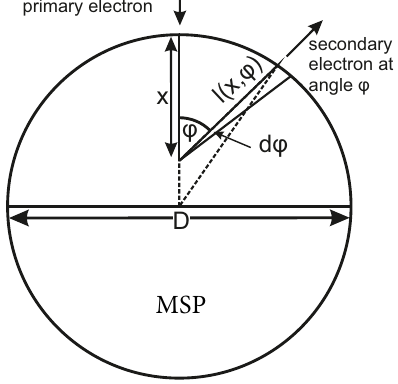
Figure 1. Principle of secondary electron emission in particles after Chow et al. (1993) (for description see